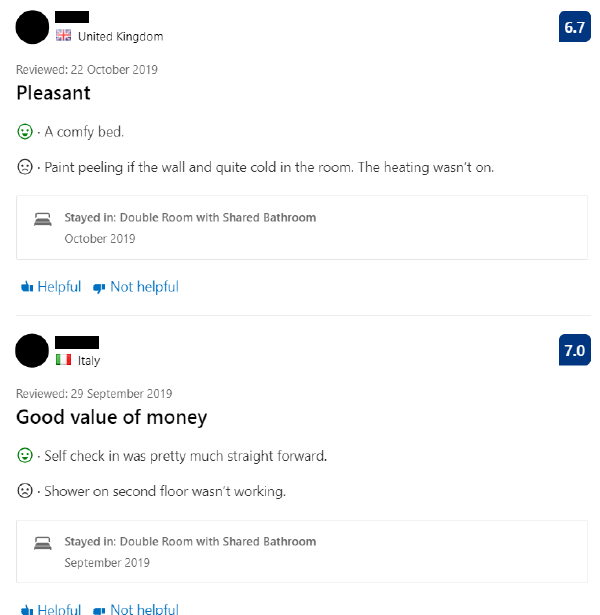
Figure 14. Examples of data collection for sentiment classification.